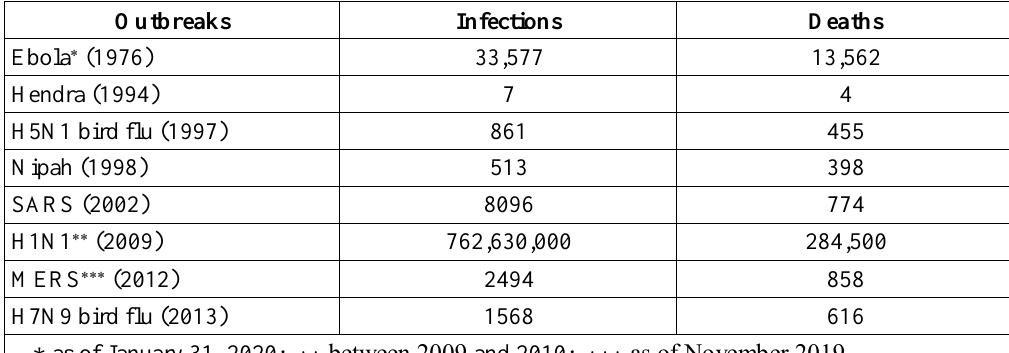
Table 1: Infections and Deaths from Viral Epidemics in Recent Years